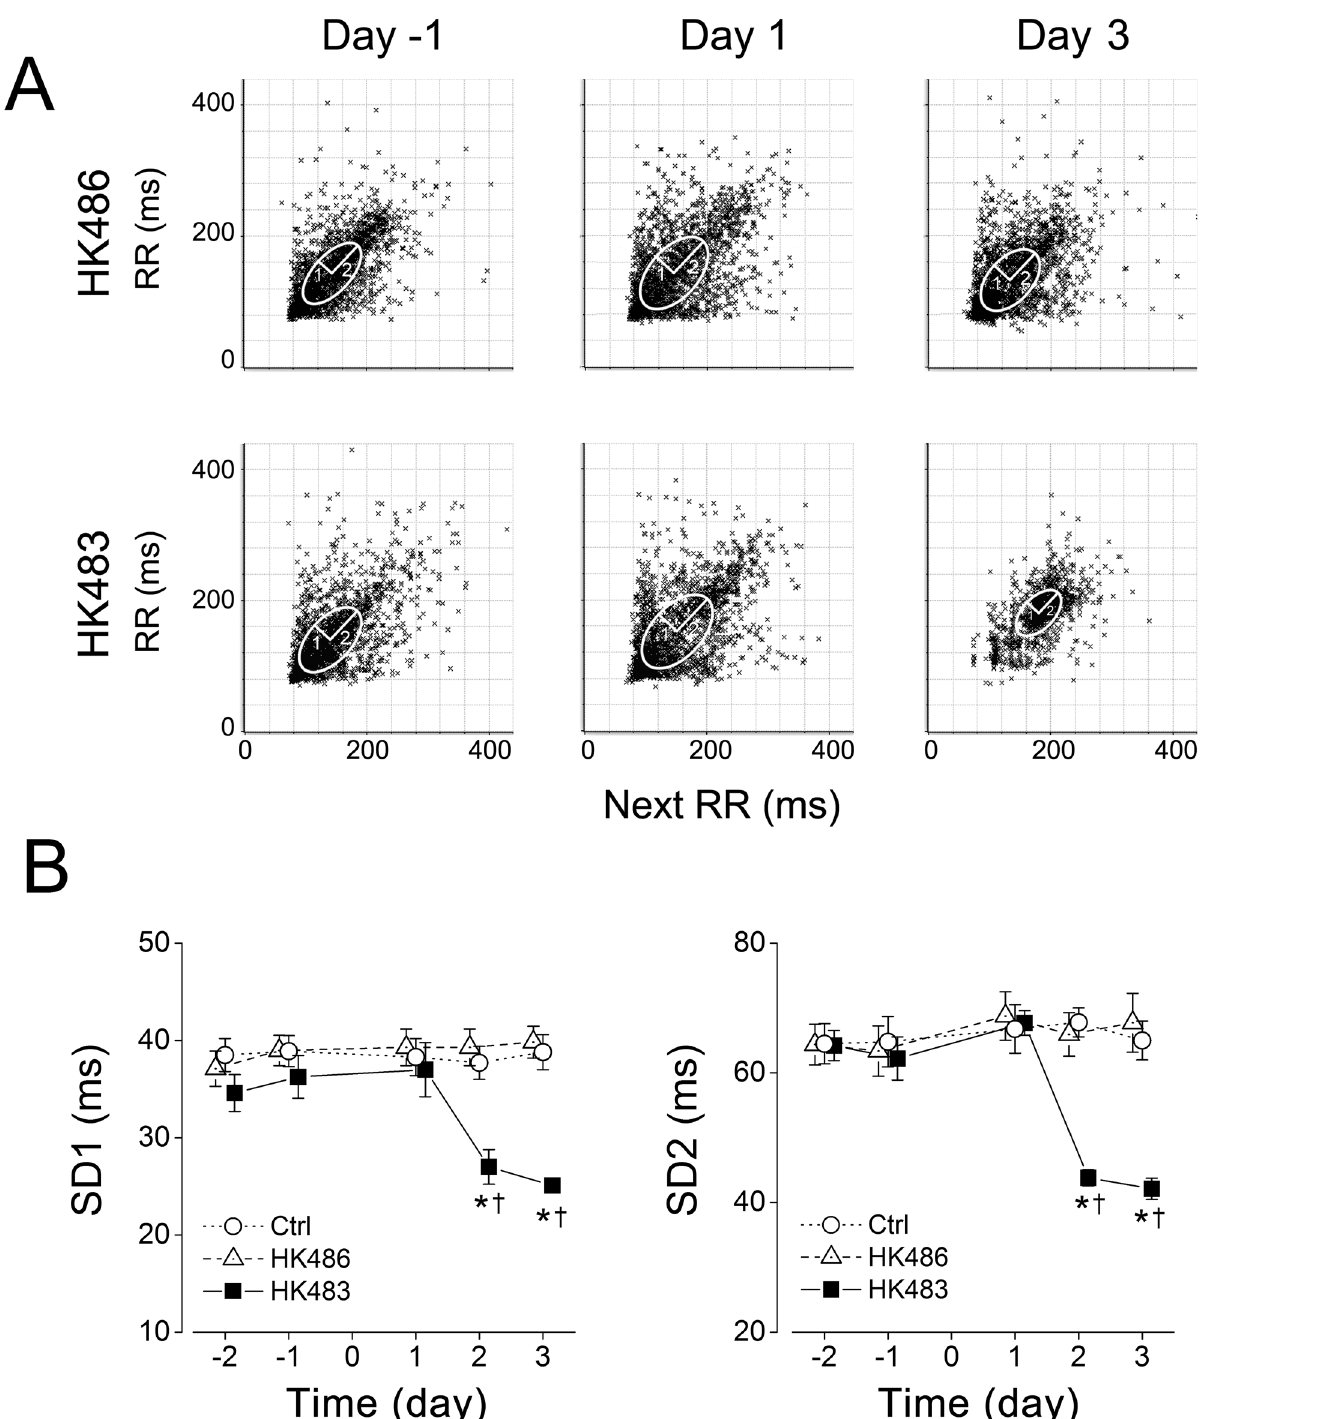
Fig 3. Effects of H5N1 viral infection on the variation of the baseline respiratory intervals (RR). RR was daily measured in the individual Ctrl, HK483 and HK486 mouse at 2 and 1 days before and 1, 2, and 3 days after intranasal inoculation (Day -2, -1, 1, 2, and 3). A: Poincare plots of RR in an HK486 and an HK483 mice before inoculation (Day -1) and at 1 and 3 days after intranasal inoculation (Day 1, 3). The area of the ellipse describes the distribution of the points with the width of the variation perpendicular to (SD1) and along the line of identify (SD2) [27]. B: Group data of the variability of baseline respiratory intervals (2500 intervals) in each group. Mean ± SE. n = 6, 15, and 7 for Ctrl, HK483 and HK486 mice. * P < 0.01 compared to the previous time-points; † P < 0.01, compared to Ctrl and HK486 at the given day. A less RR variation is observed after HK483 but not HK486 viral infection at 2 and 3 dpi.